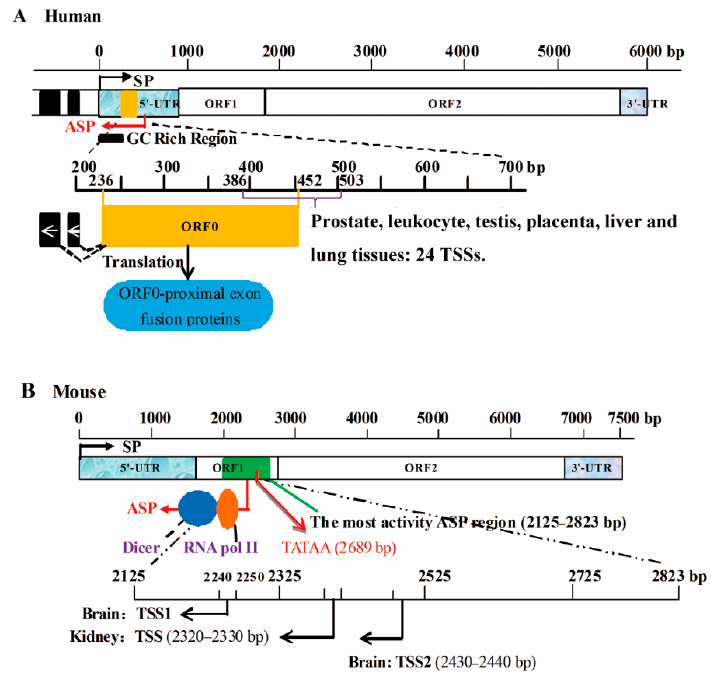
Figure 2. Schematic representation of the position of L1 ASPs in humans and mice. ( A ) The L1 5 ′ -UTR (human) harbors an ASP (red reverse arrow) and a SP (black arrow) [36,37]; the mouse L1 ASP (red arrow showed in ( B ) is within ORF1 [37]. The G-C base rich (GC-rich) region (0–485 bp, black box) plays a role in the activity of the L1 ASP. There are 24 TSSs (transcription start sites) in purple arrow mapped to the opposite strand of the L1 5 ′ -UTR. Interestingly, the L1 ASP functions as an alternative promoter, generating not only antisense transcripts, but also chimeric mRNAs [36]. ORF0 (yellow rectangle), a primate-specific open reading frame-0 located in 236–452 bp, not only contributes to the generation of ORF0-proximal exon fusion proteins but also enhances L1 mobility and there are 24 TSSs of various tissues located in 386–503 bp (purple bracket) [25]. The wright arrows means the transcriptional direction of ORF0, and the black dotted line and connected black boxes represent its transcript alternative splicing; ( B ) The mouse L1 ASP is located in ORF1, which includes a TATAA sequence at 2689 bp (orange arrow) and the ASP region with the highest activity from 2125 to 2823 bp (green frame) [37]. It has been demonstrated that RNA polymerase II (orange circle) and Dicer (blue circle) participate in the L1 ASP transcriptional initiation complex, with the latter playing a modest role in limiting native L1 retrotransposition. There are also different TSSs located in the L1 ASP, such as brain tissue-specific TSSs located at 2240–2250 bp and 2430–2440 bp (black reverse arrow); a kidney-specific TSS is located at 2320–2330 bp (black reverse arrow). The difference between the L1 ASPs of humans and mice is due to evolutionary events [3].